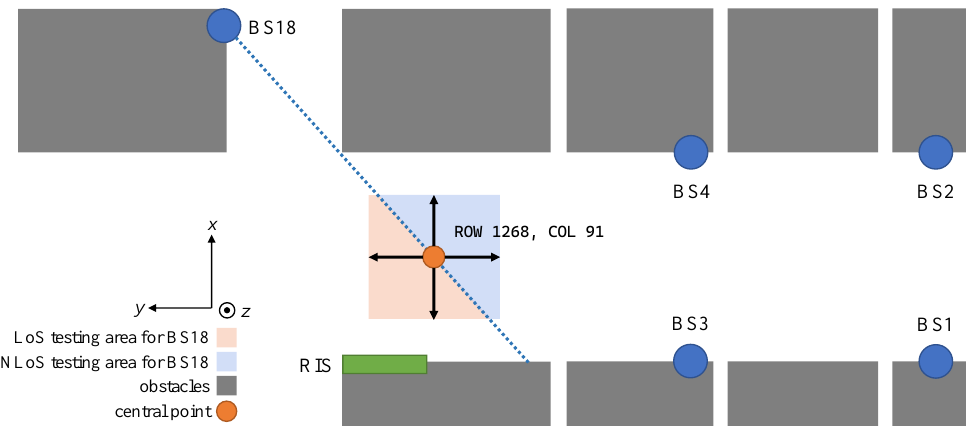
Figure 14. A top-view sketch map of the experimental area using the O1 scenario in the